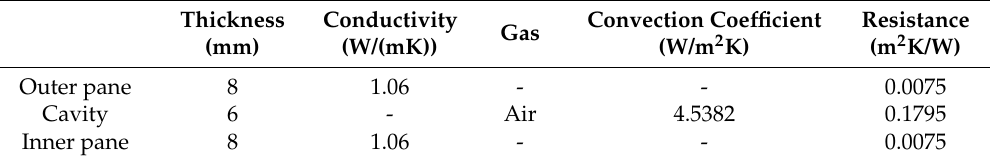
Table 7. Details of CLT external window design in Beijing.